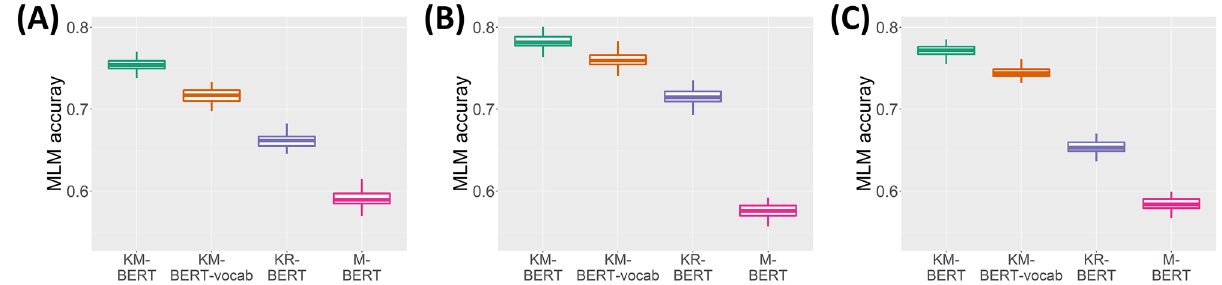
Figure 3. Distribution of MLM accuracy by 100 repetitions for each language model over each corpus type. ( A ) Medical textbook. ( B ) Health information news. ( C ) Medical research